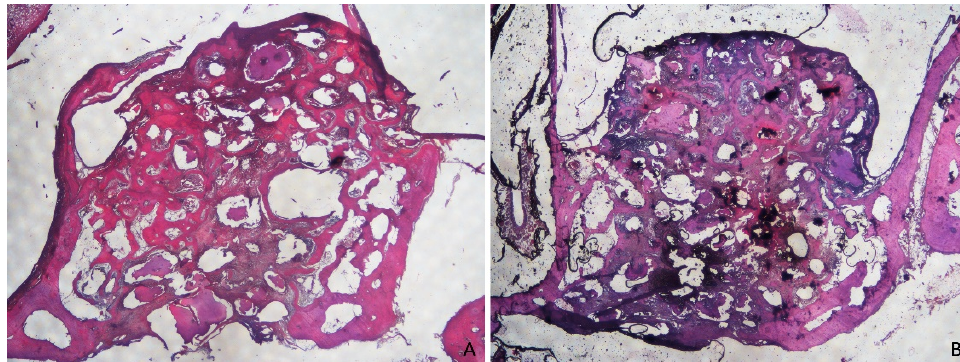
Figure 8. ( A ) Merged images from photomicrographs of sections of decalcified samples representing the healing after 8 weeks in the membrane group. Scarlet-acid fuchsine and toluidine blue. ( B ) Merged images from photomicrographs of sections of decalcified samples representing the healing after 8 weeks in non-membrane group. Scarlet-acid fuchsine and toluidine blue.